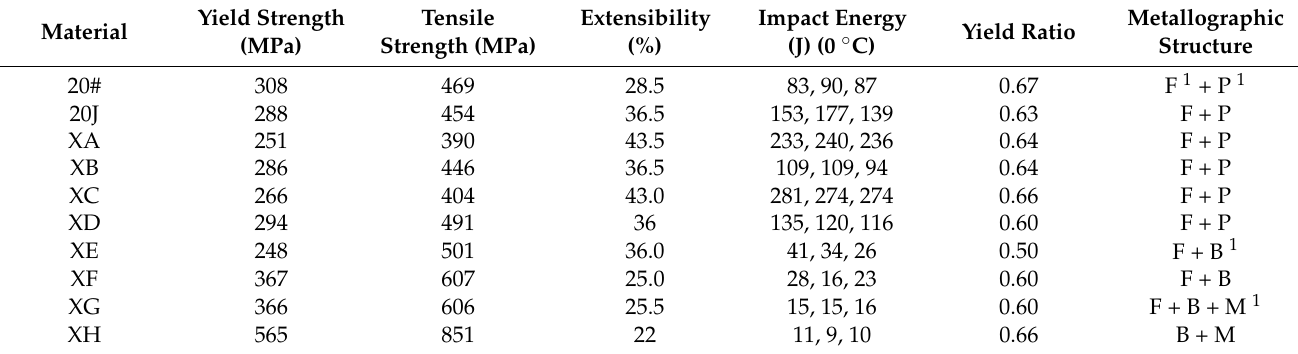
Table 11. Mechanical properties of 20# steel and optimized